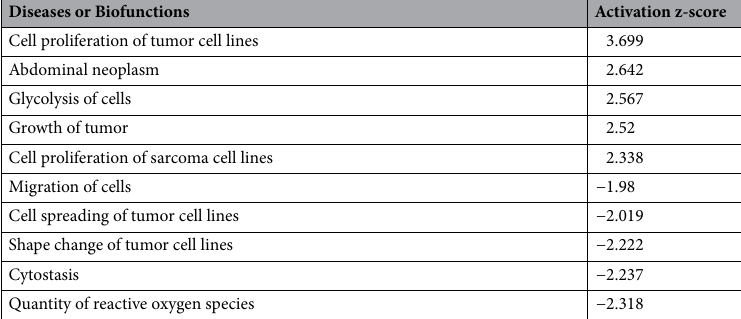
Table 2. Pathway analyses of conserved protein and transcript alterations in HLRCC versus Non-Syndromic (NS) ULMs. Table denotes top 5 functional pathways predicted to be activated (positive z-score) or inhibited (negative z-score) in HLRCC vs NS ULMs (Ingenuity pathway analyses, p-value < 0.05).